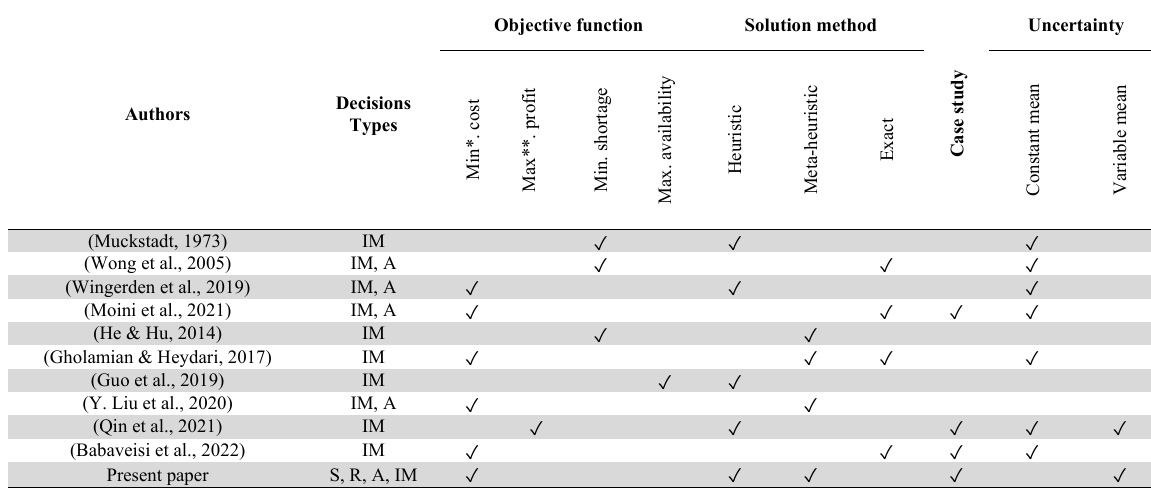
Literature review